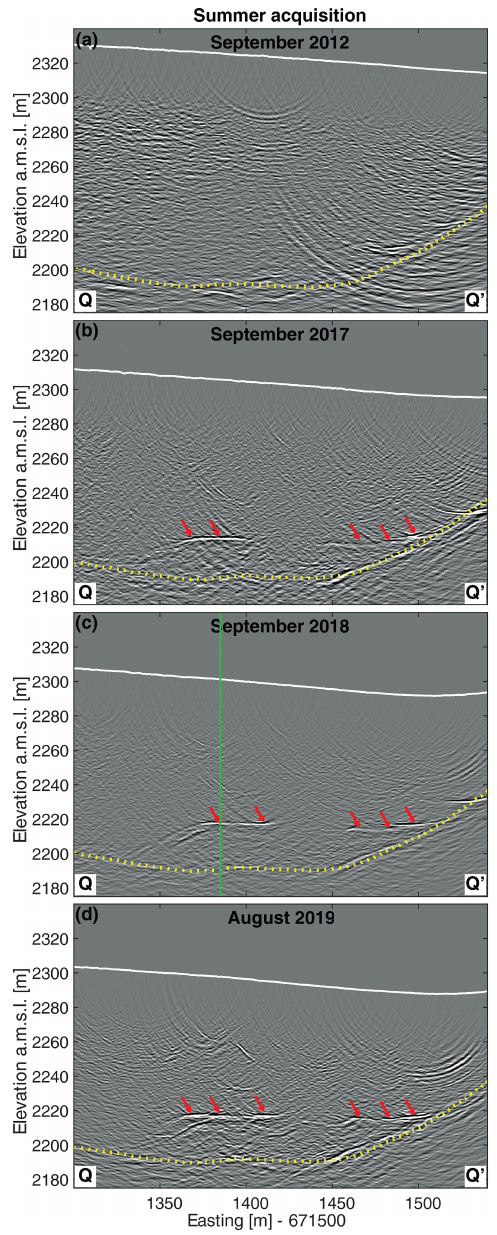
Figure 2. Annual GPR imaging results from a repeated profile (Q- Q (cid:48) in Fig. 1) over a single line after migration from 2012 until 2019. The yellow line represents the ice–bedrock interface, and the red arrows represent the englacial conduit network reflection appearing from summer 2017. The green line in (c) marks the location of the CMP acquired. Zoomed GPR profile images are available in Fig. S1 in the